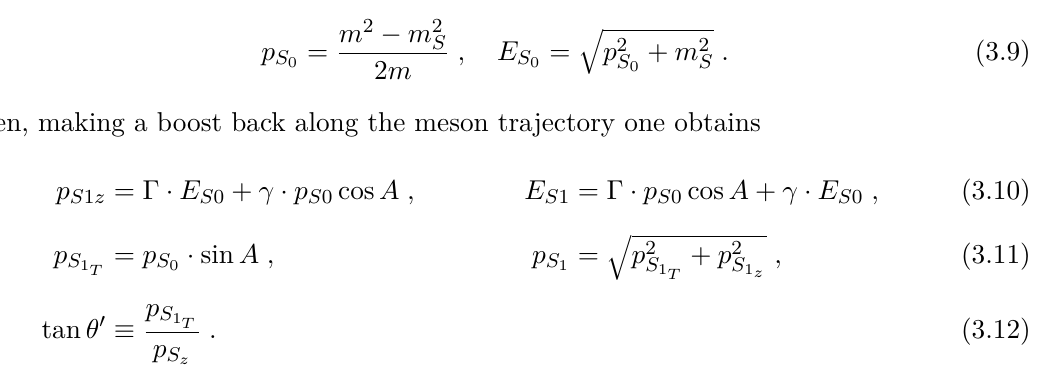
JHEP08(2022)155